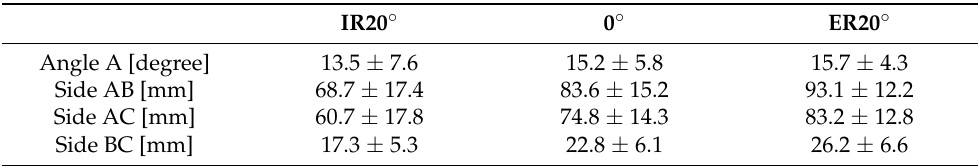
Table 2. Measurements of Sides AB, AC, and BC, and Angle A according to the three shoulder positions.